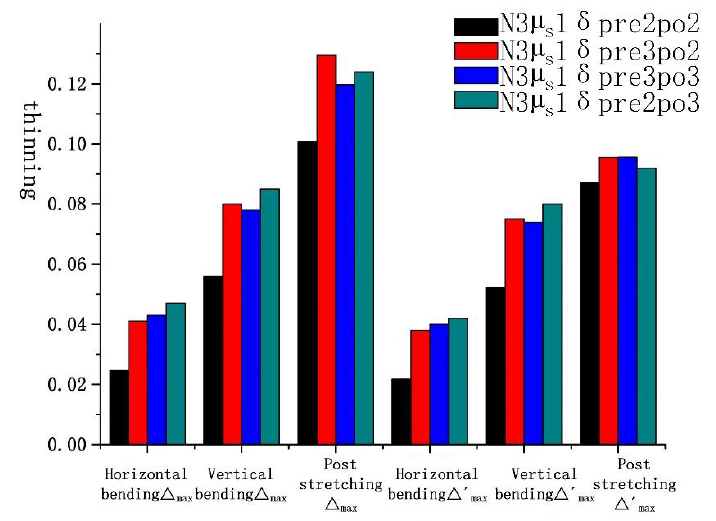
Figure 10. Experimental